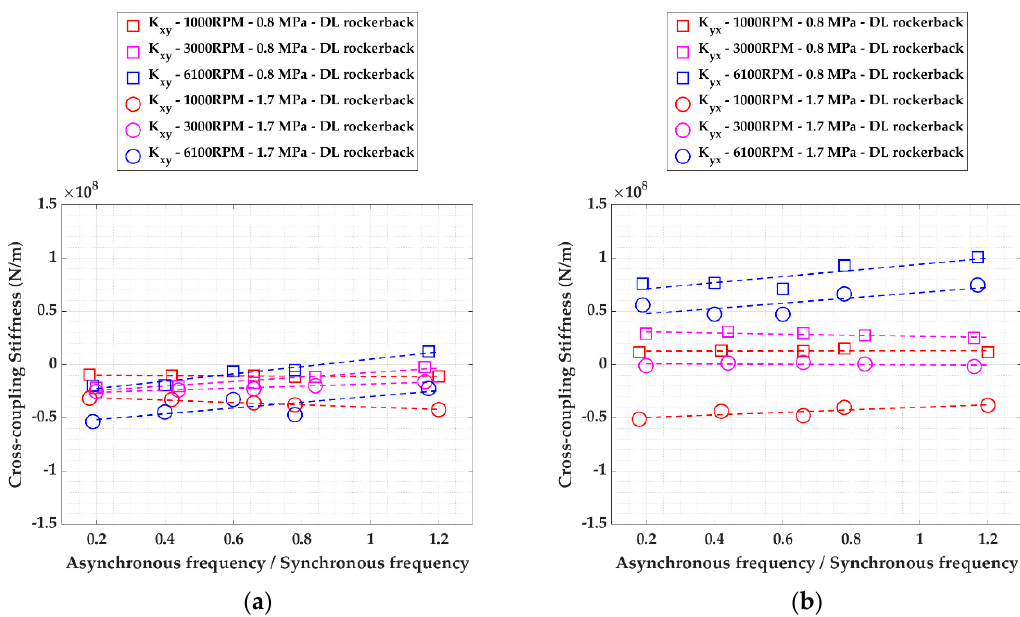
Figure A5. Direct Lube Rocker Pivot bearing asynchronous cross-coupling stiffness coefficients at various speeds for 0.8 MPa and 1.7 MPa: ( a ) K xy , ( b ) K yx .